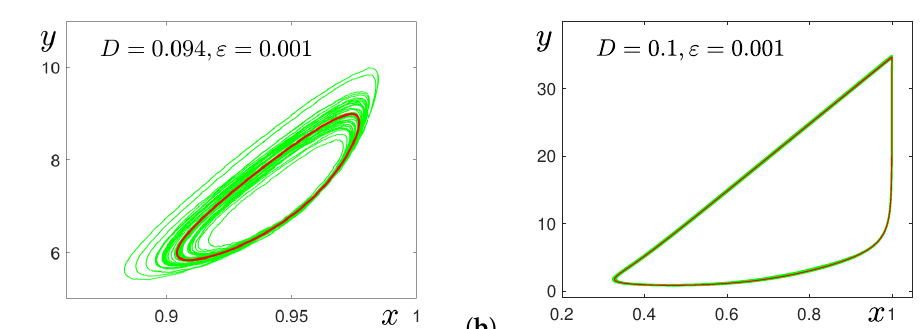
Figure 4. Deterministic limit cycles (red) and random trajectories (green) of stochastic system (2), with ε = 0.001 for ( a ) D = 0.094, ( b ) D = 0.1.